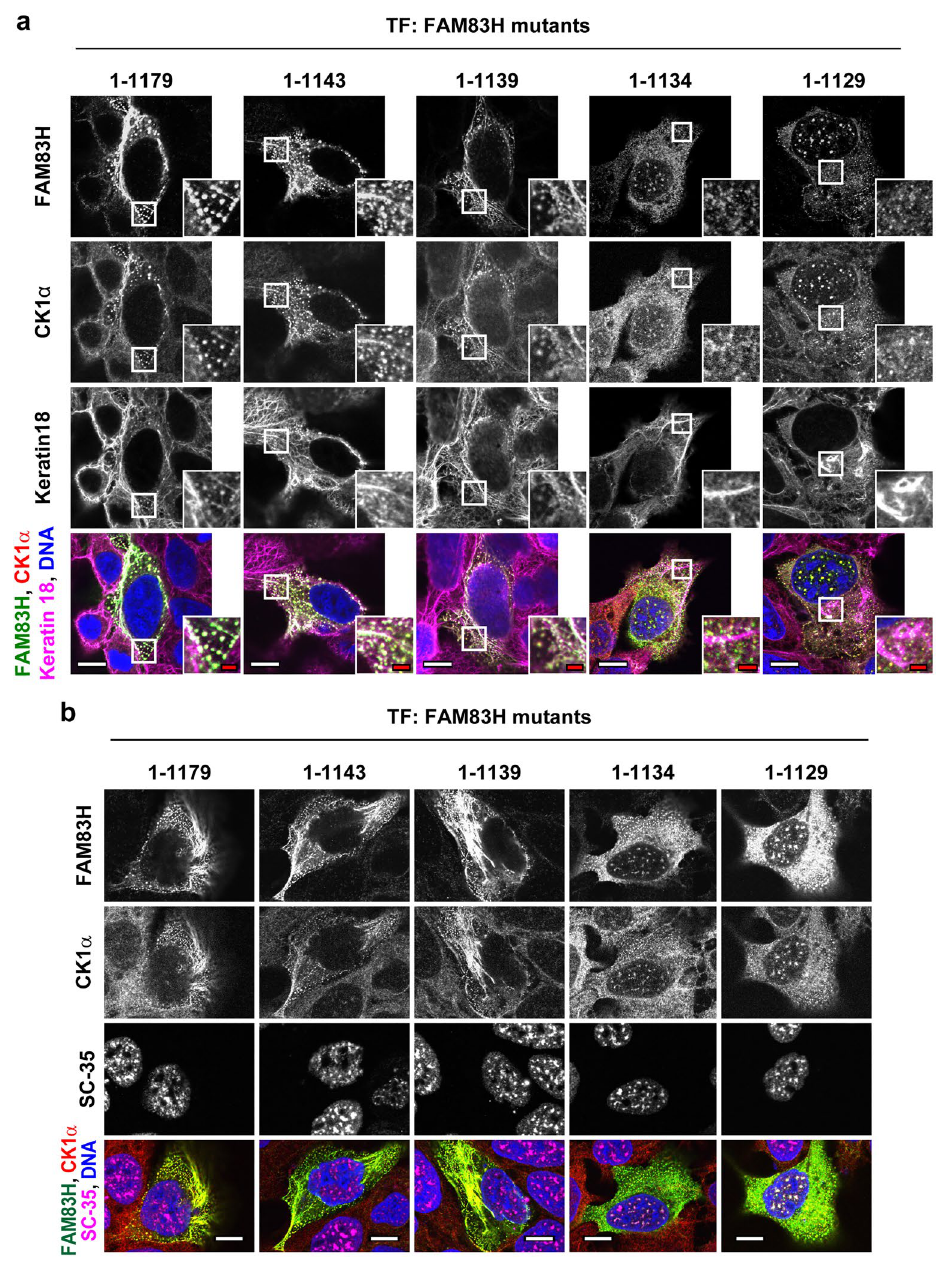
Figure 4. Deletion of amino acid residues 1134–1139 of FAM83H results in its translocation from the keratin cytoskeleton to the nuclear speckles. DLD1 cells were transfected with the plasmids encoding the indicated FAM83H mutants and were analyzed via immunofluorescence using antibodies for ( a ) FAM83H (green), CK1α (red), and keratin 18 (magenta) or ( b ) FAM83H (green), CK1α (red), and SC-35 (magenta). Nuclei were visualized by DAPI (blue). ( a ) Magnified images at the regions enclosed by white squares are shown. White and red scale bars indicate 10 and 2 μm,